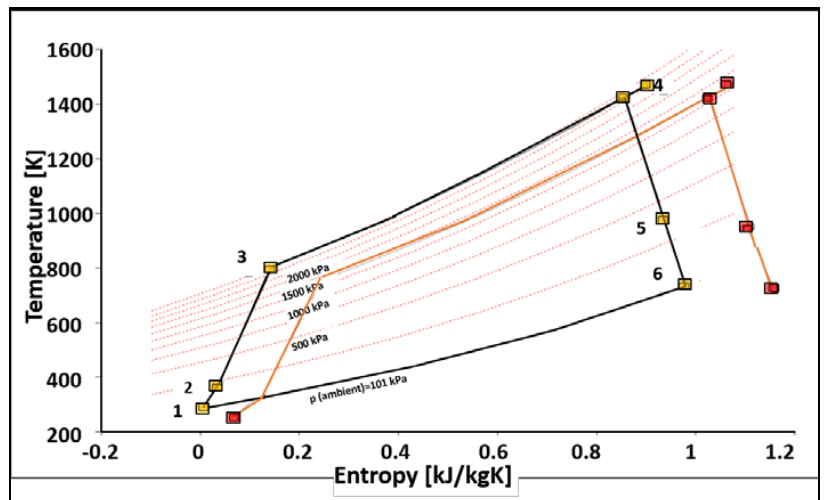
Figure 7. Thermodynamic cycles for two points of the flight mission.